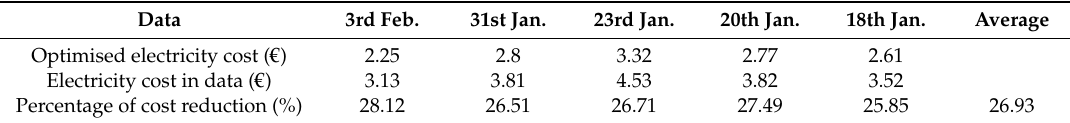
Table 4. Summary of results of the improved QPSOL for five cold winter days in 2019.